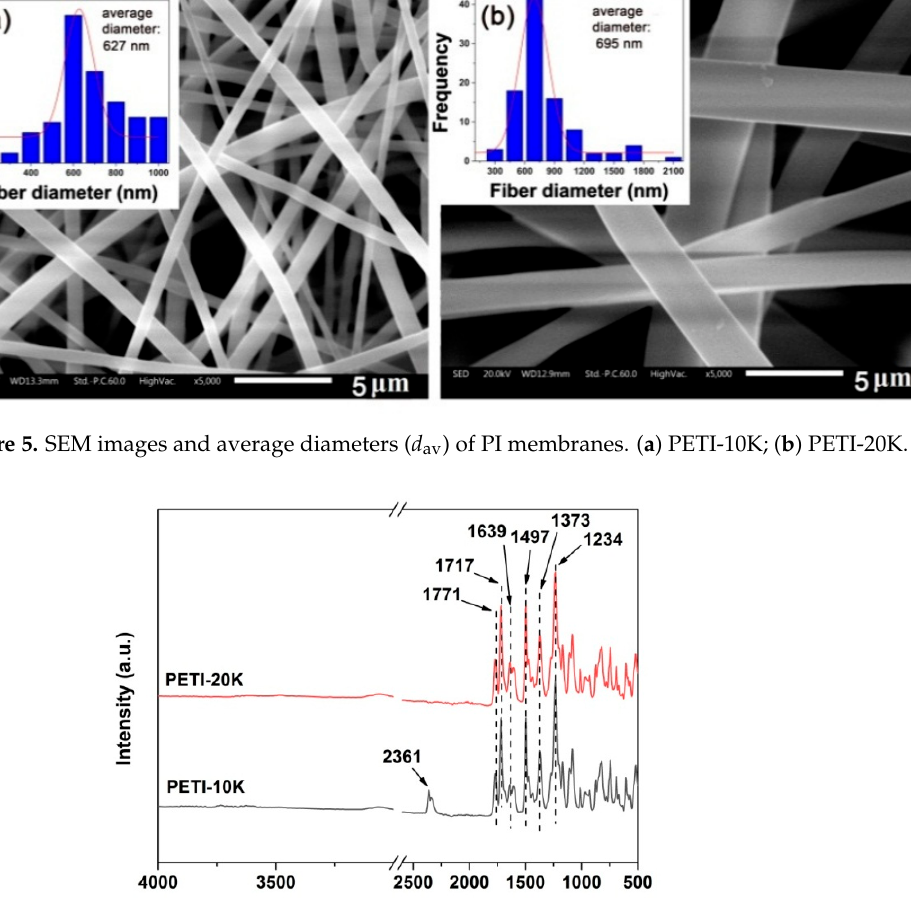
Figure 4. ( a ) Fabrication procedure of PI membranes via electrospinning; ( b ) Fabrication of stainless steel samples for lap shear strength (LSS) measurements; ( c ) Diagram for the sizes of adhesion samples.